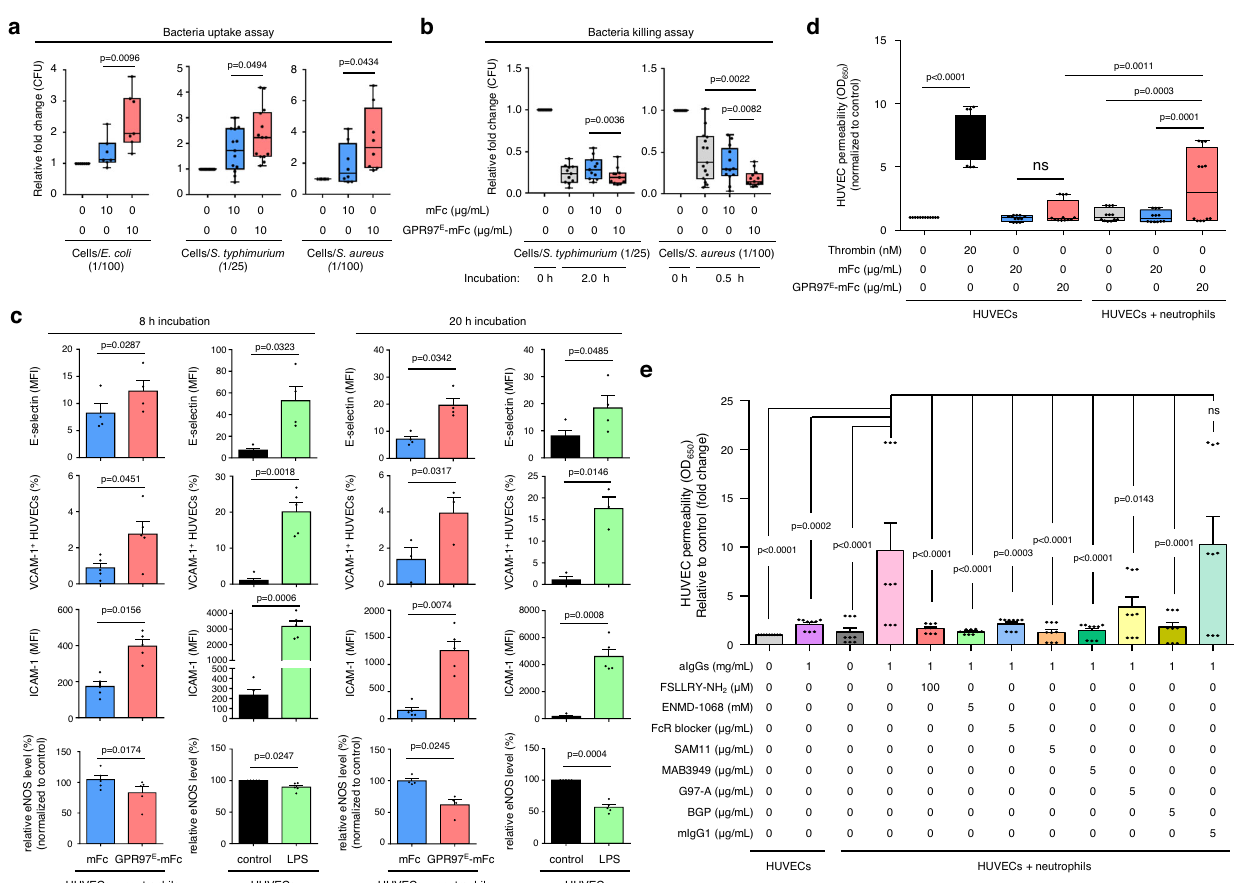
Fig. 7 | GPR97-mediated PAR2 activation enhances neutrophil-mediated bac- terial phagocytosis and killing as well as endothelial cell activation and dys- function. a , b Phagocytosis a and killing b of live bacteria ( E. coli n =10, S. typhimuriumn =13forphagocytosisassay n =11forkillingassay,and S.aureusn =8 for phagocytosis assay n =11 for killing assay) by neutrophils incubated without or withGPR97 E -mFc.mFcwasincluded asanegativecontrol.Dataaremeans±SEM. P value was determined by one-way ANOVA. c The expressional analyses of cell activation markers (E-selectin, ICAM-1, VCAM-1 and eNOS) of HUVECs co-cultured with neutrophilsinthe absenceor presence of GPR97 E -mFc. mFc wasincludedasa negativecontrol.HUVECstreatedwithoutorwithLPSwereusedasanegativeanda positive control, respectively. n =3 independent experiments. Data are means± SEM and p value was determined by two-sided unpaired student ’ s t-test.